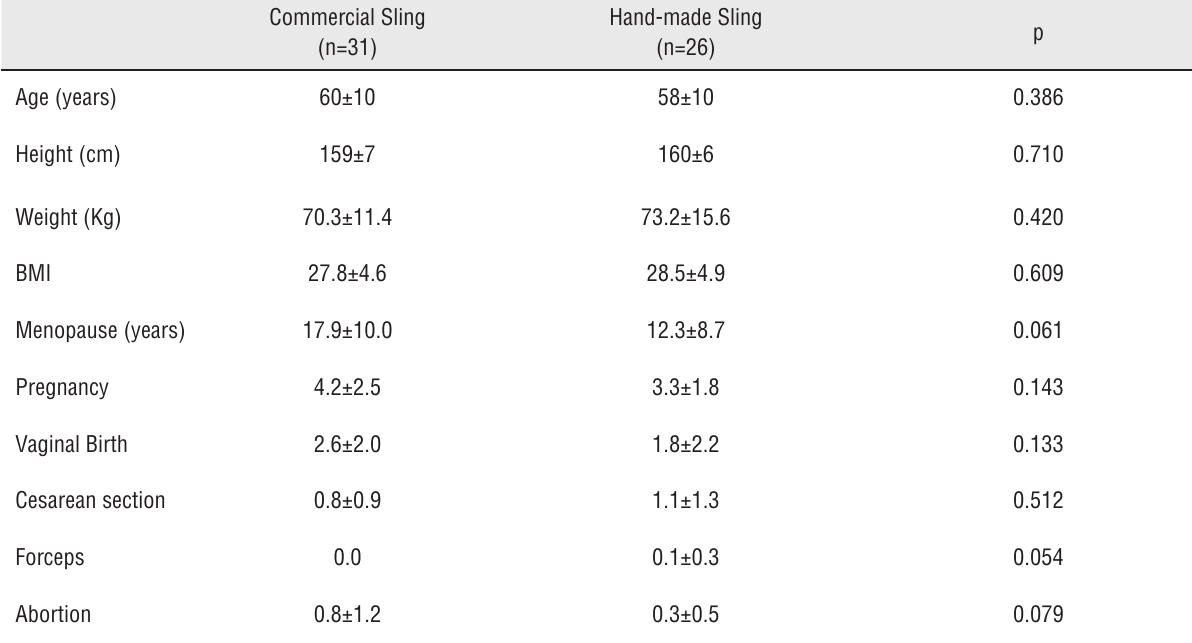
Table 1 - Demographic data (meanstandard deviation).